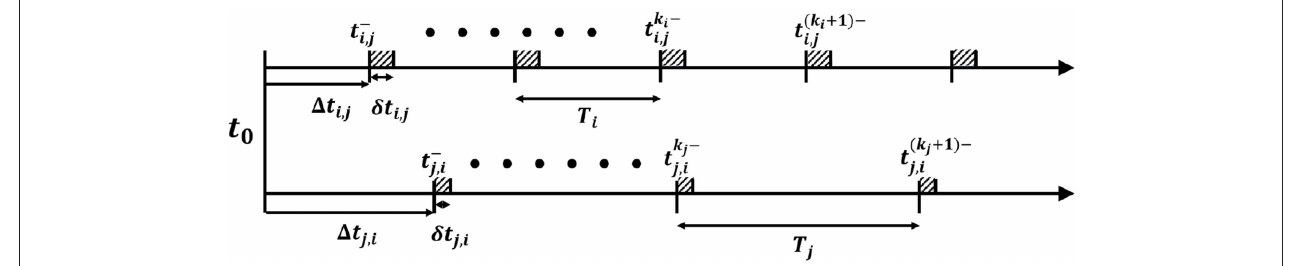
FIGURE 6 | Time schedule for a pair of agents. Shaded parts indicate the time the agents spent in the rendezvous zone. A rendezvous will occur if and only if there is an overlap between shaded parts on both axis.